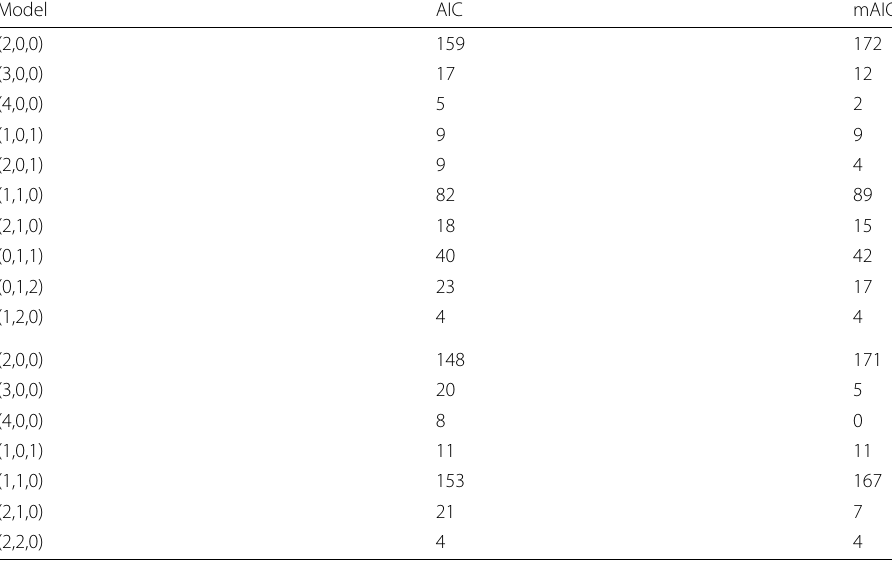
Table 4 Amount of time series per cluster 2016 and